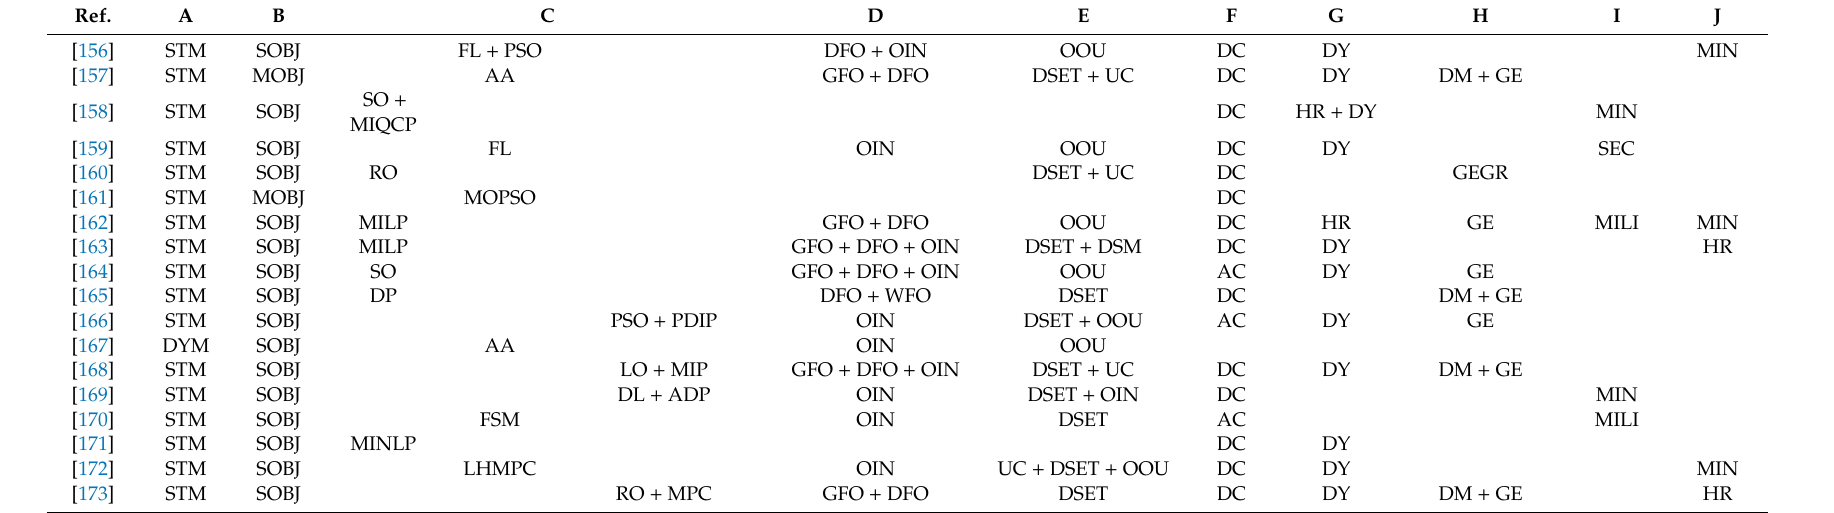
Table A10. Papers published in